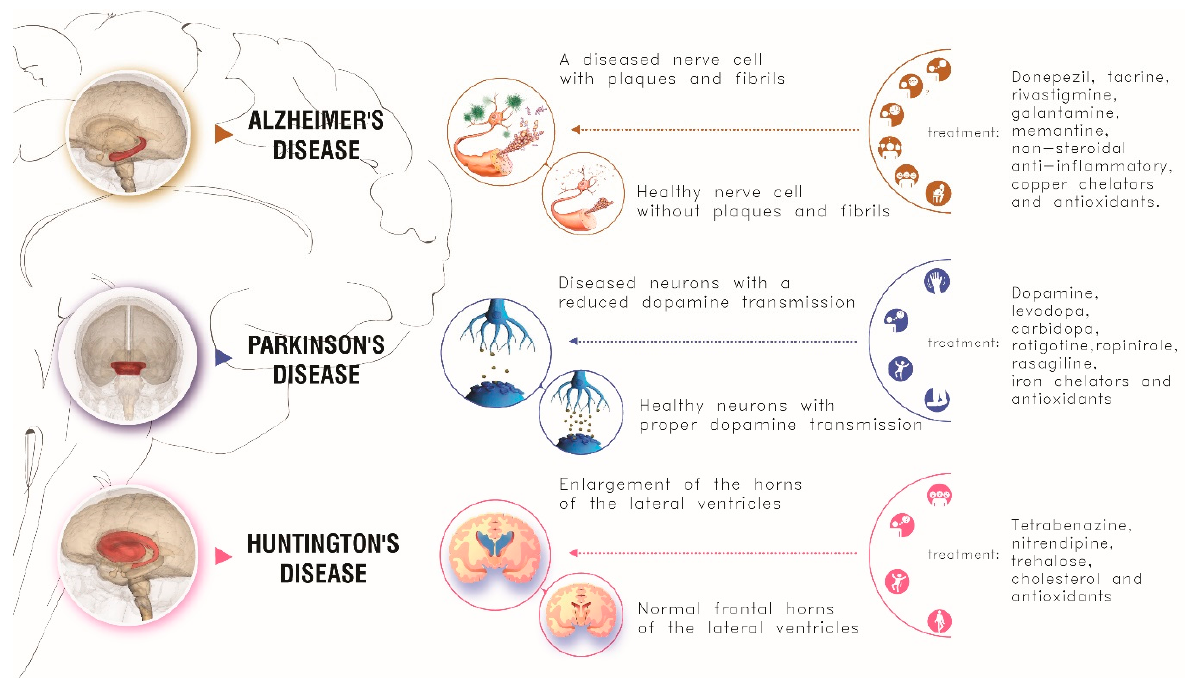
Figure 4. Main causes, symptoms and conventional treatments for the main three neurodegenerative disorders here described.